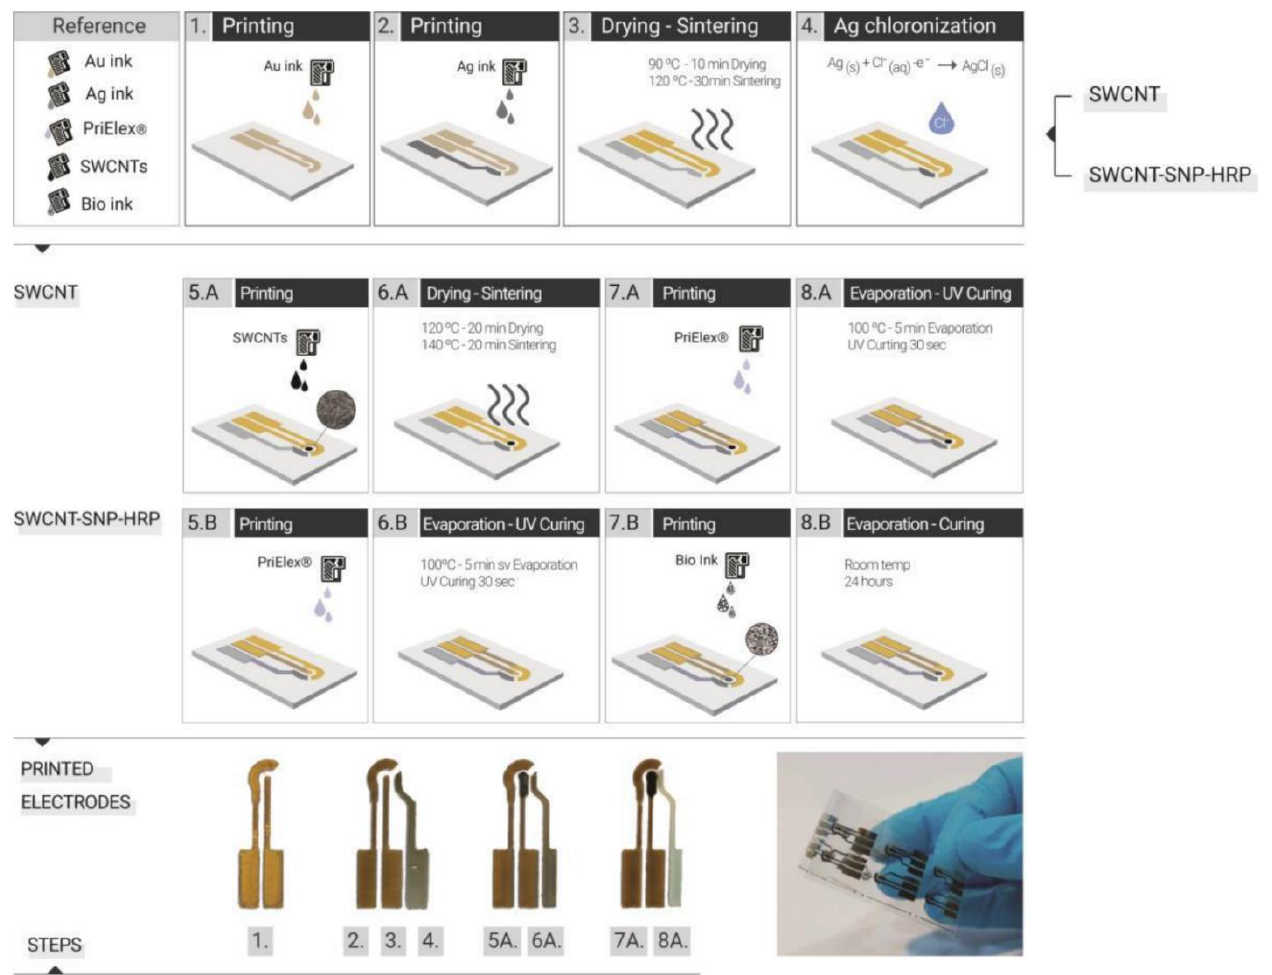
Figure 5. (TOP) Illustration showing the inkjet-printed fabrication steps of the three-electrode electrochemical cell. Polyethylene Terephthalate (PET) was chosen as the substrate. (1–4) Initially, the working electrode (WE) and counter electrode (CE) were printed with Au nanoparticle ink, followed by the printing of the reference electrode (RE) with Ag nanoparticles. After the drying and sintering stage, the Ag electrode was chlorinated for stability purposes. (5.A–8.A) In the next step, a circular area (1 mm dia) was printed on WE with CNT ink, followed by the sintering step. The PriElex ® SU8 dielectric ink was printed on the conductive paths, followed by hotplate curing. (5.B–8.B) In the final step, following the printing and curing of the dielectric ink, the bio-ink (SWCNT-SNP-HRP) was printed on the active area of WE, followed by room temperature curing to avoid damages and losses in enzymatic activity. (Bottom) Photographic images of the printed electrodes inks and the image of multiple electrodes inkjet printed on flexible PET substrate. Reprinted with permission from [175].